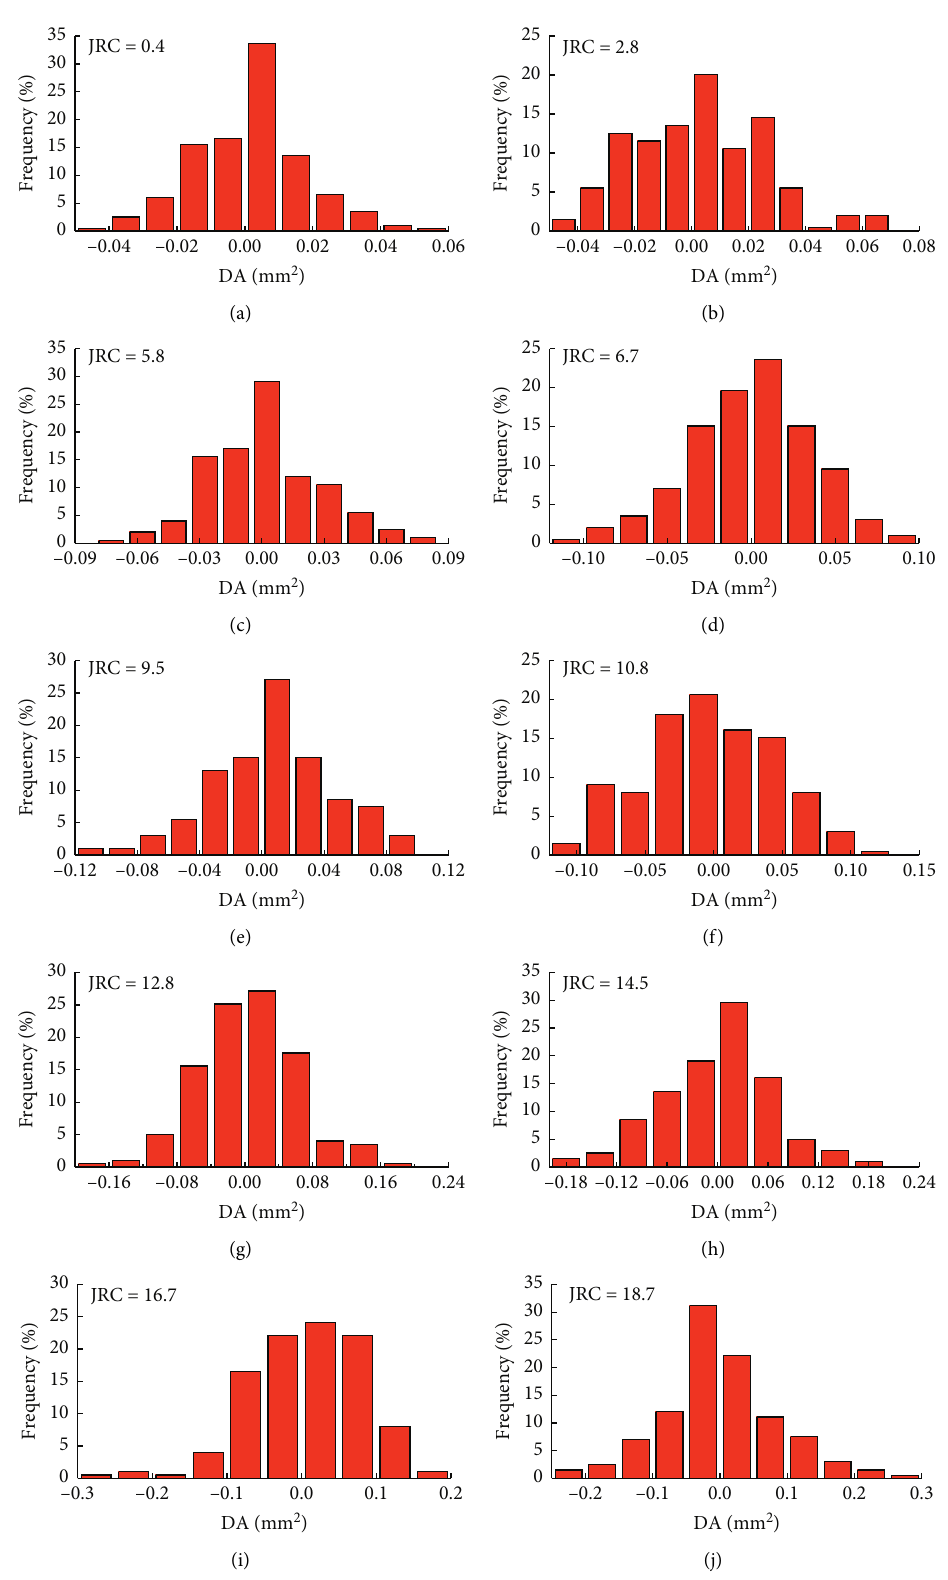
Figure 10: The distribution of DA calculated from standard roughness profiles. (a) Profile 1. (b) Profile 2. (c) Profile 3. (d) Profile 4. (e) Profile 5. (f) Profile 6. (g) Profile 7. (h) Profile 8. (i) Profile 9. (j) Profile